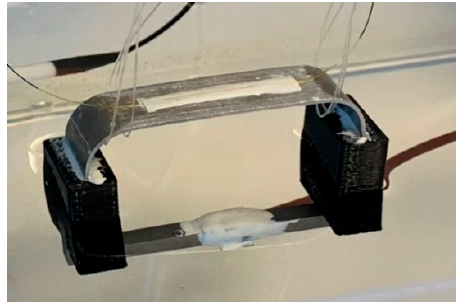
Figure 8. Corrosion sensor with an optical fiber with many FBG sensors.